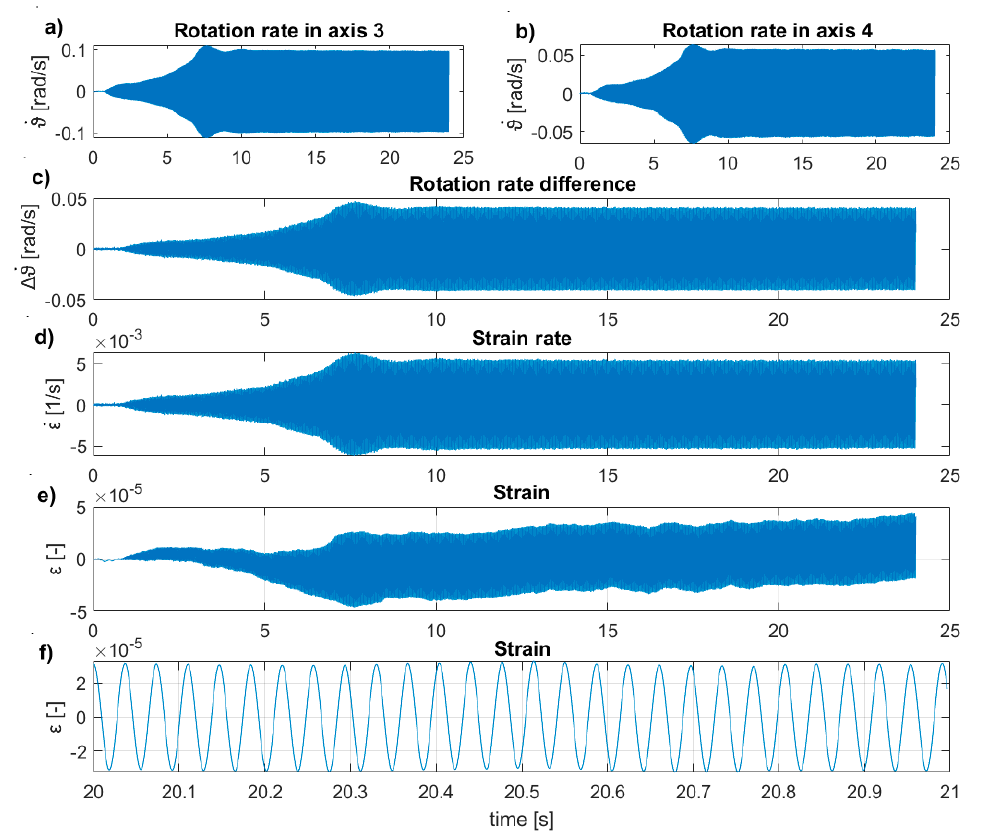
Figure 13. Result for the intact UHPC2_L beam induced by the inertial vibration exciter with 27.26 Hz. ( a ) Rotation rate at axis three, ( b ) rotation rate at the axis, ( c ) difference in rotation rate between axis three and axis four, ( d ) average strain rate between axis three and axis four, ( e ) average strains between axis three and axis four, and ( f ) short time window of average strains between axis three and axis four.